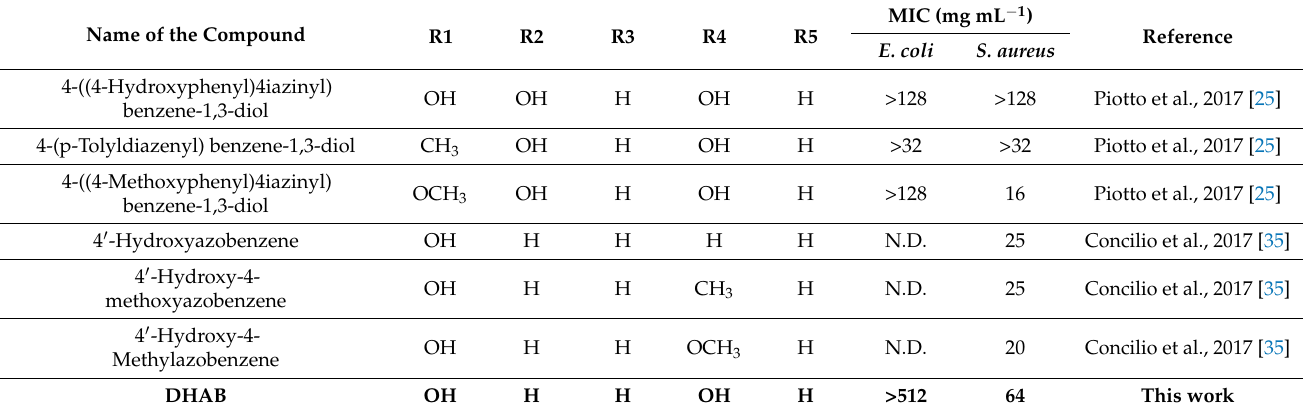
Figure 2. Structure of azo compounds tested as antimicrobial substances. Table 2. MIC for different azo compounds against E. coli and S. aureus . N.D., not determined.